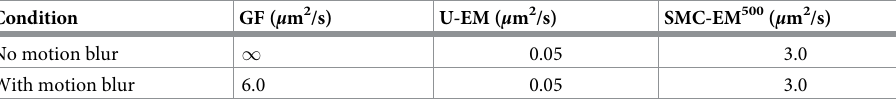
Table 3. Diffusion coefficient threshold before localization failure with G = 100, N bgd =